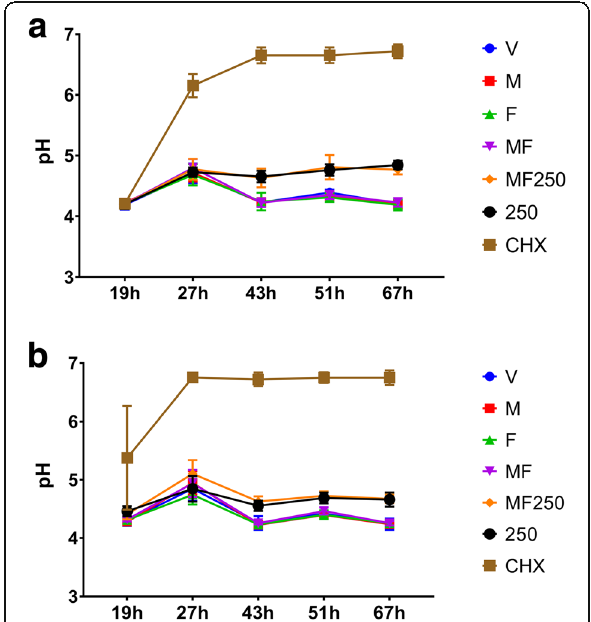
Fig. 2 pH of spent media of treated biofilms. a Represents the data generated for regimen one, while ( b ) for regimen two. The pH values were measured when the culture media was changed. V: vehicle; F: tt- farnesol; M: myricetin; MF: tt -farnesol + myricetin; MF250: fluoride + tt- farnesol + myricetin; 250: fluoride (250 ppm); CHX: chlorhexidine. The data shown are averages, and error bars indicate the standard deviation. Statistical analysis is not depicted in the